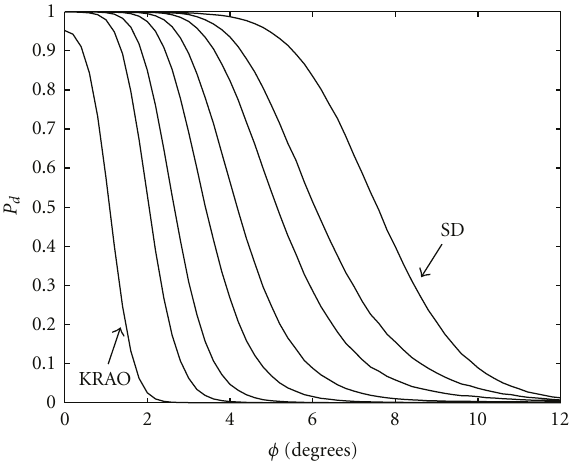
Figure 10: P d versus φ for the SKRAO-ASB with N = 8, K = 24, ρ = 1 . 2, H = [ s (0), s ( π/ 360)], and SNR = 18dB.